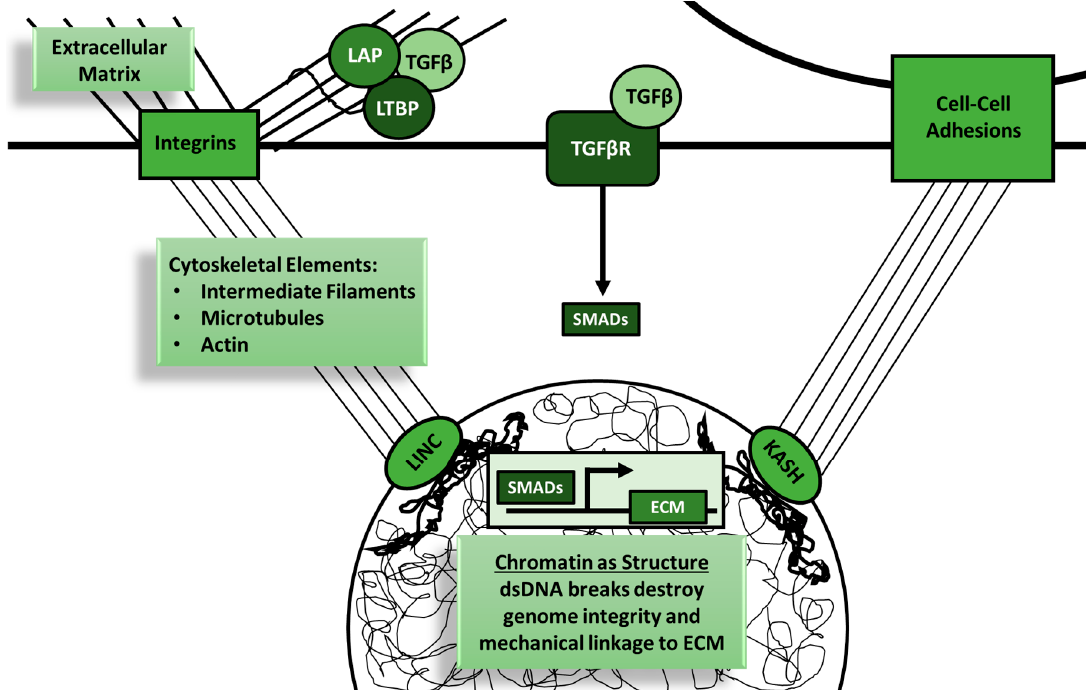
Figure 3. Transforming growth factor β (TGF- β ) signaling is intimately linked with the mechanobiology of cells. Dynamic reciprocity is the concept of bidirectional influence of cells and their microenvironment, including adhesions to the extracellular matrix (ECM) and to surrounding cells. Physical linkages between the extracellular microenvironment are created by plasma membrane adhesion receptors, the cytoskeleton, nuclear membrane KASH (Klarsicht, ANC-1, Syne Homology)- and SUN (Sad1p, UNC-84)-domain proteins, and chromatin. KASH- and SUN-domain proteins bind to each other to form linker of nucleoskeleton and cytoskeleton (LINC) complexes that connect the cytoskeleton to the nucleoskeleton. TGF- β signaling plays an important role in this dynamic reciprocity at both the ECM and nuclear levels. Inactive TGF- β binds to latency-associated peptide (LAP) or latent TGF- β binding proteins (LTBPs) in the ECM. ECM degradation or remodeling relieves mechanical tension on the cell down to the nuclear level while simultaneously increasing the bioavailability of active TGF- β . DNA damage can also decrease the structural integrity of this mechanical tension. TGF- β signaling restores this mechanical homeostasis through upregulation of ECM components and DNA repair enzymes. Tumor cells with elevated TGF- β signaling are able to restore mechanical homeostasis despite ongoing ECM remodeling and DNA damage.